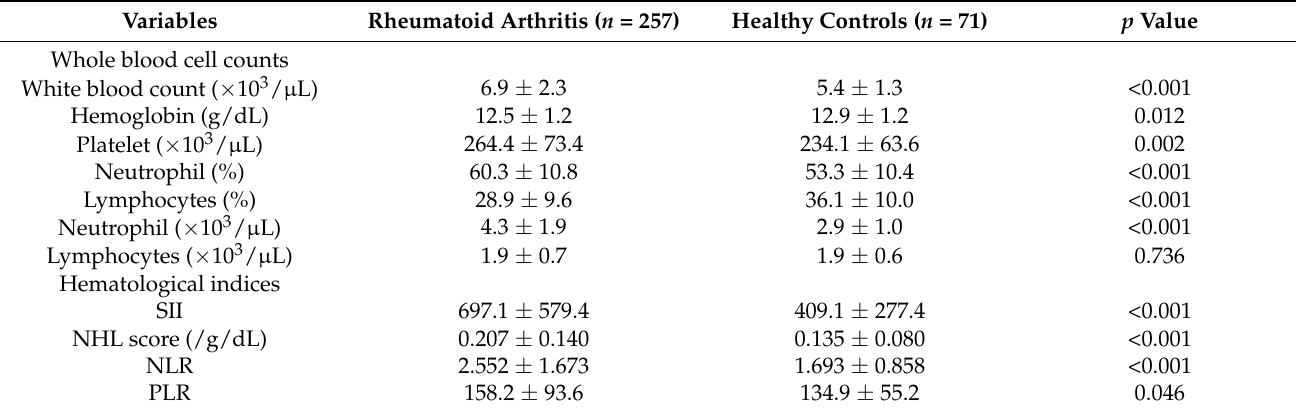
Table 2. Comparison of hematological indices between rheumatoid arthritis and